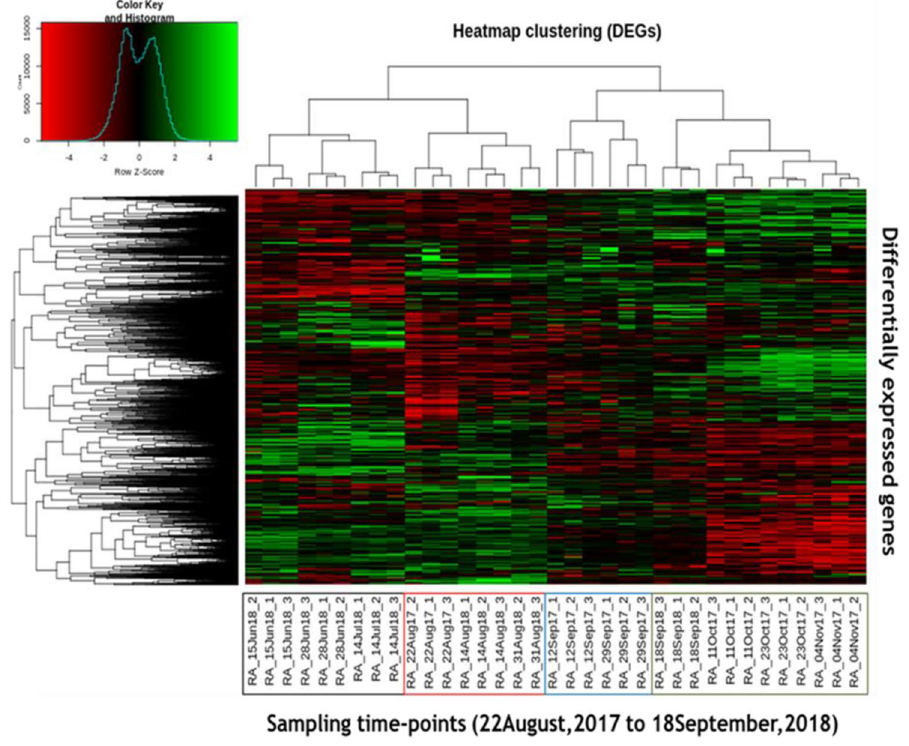
Figure 3. Hierarchical clustering based on expression levels of differentially expressed genes of R. anthopogon during the study period (from 22 August, 2017 to 18 September,